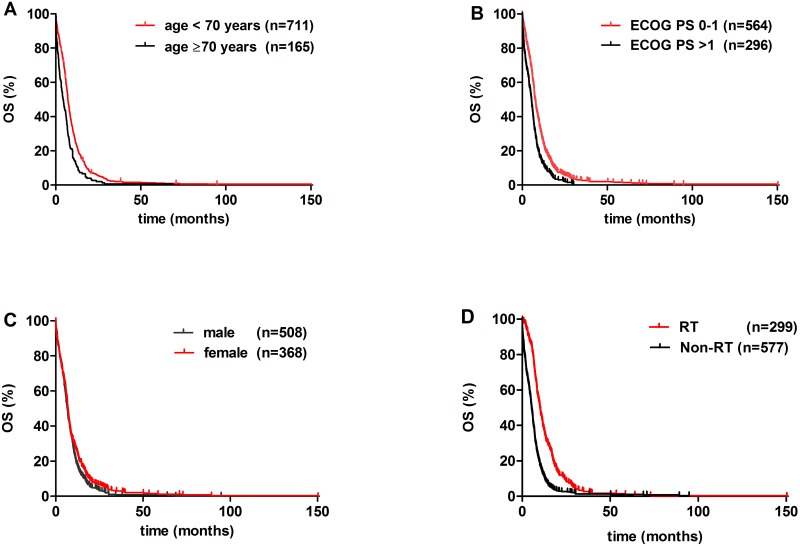
Kaplan-Meier curves for the OS of clinical variables of metastatic SCLC patients.(A) age <70 yrs vs. ≥70yrs (p = 0.001), (B) ECOG PS 0–1 vs. ECOG PS >1 (p<0.001), (C) male (vs. female; p = 0.021), and (D) radiation therapy (RT) vs. patients not treated with RT (p<0.001).